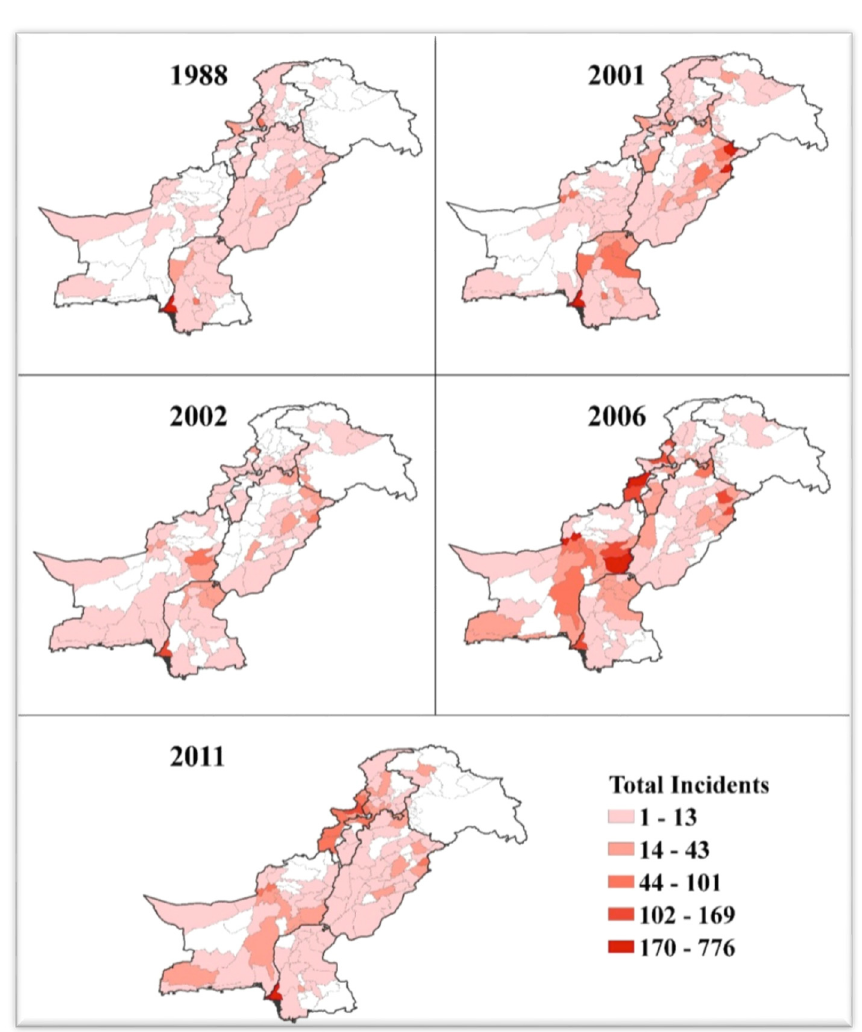
Figure 1. All Political Violence in Pakistan-Selected Years. Source: In-house manipulations of BFRS dataset [29,61] by Jesse